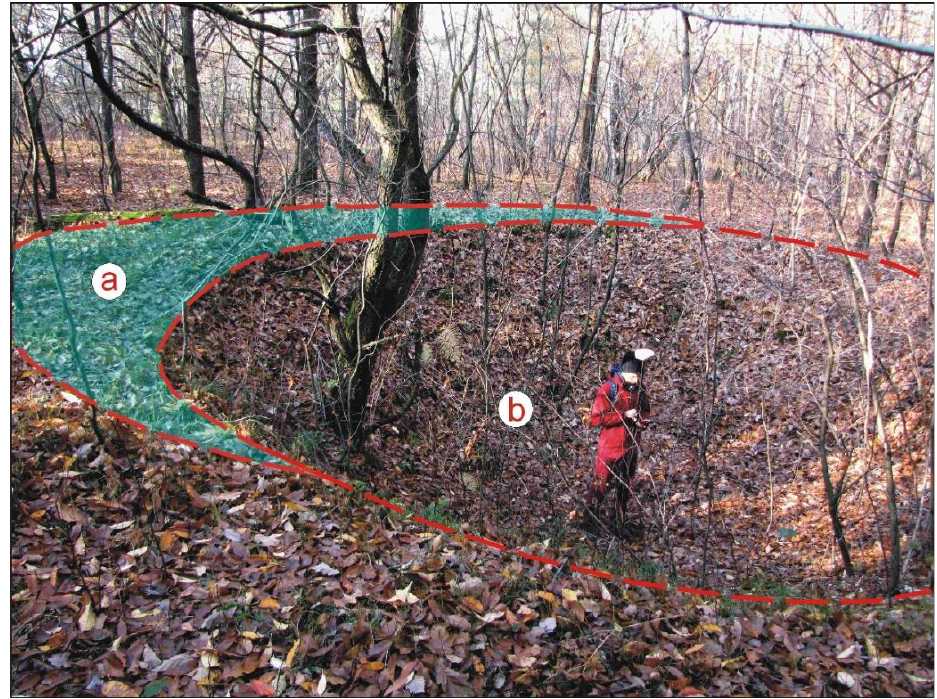
Figure 7. Remnants of a charcoal pile partially destroyed by a bomb explosion during World War II: (a) charcoal pile remnants; (b) bomb crater (photo: J.M. Waga). ( a ) charcoal pile remnants; ( b ) bomb crater (photo: J.M.